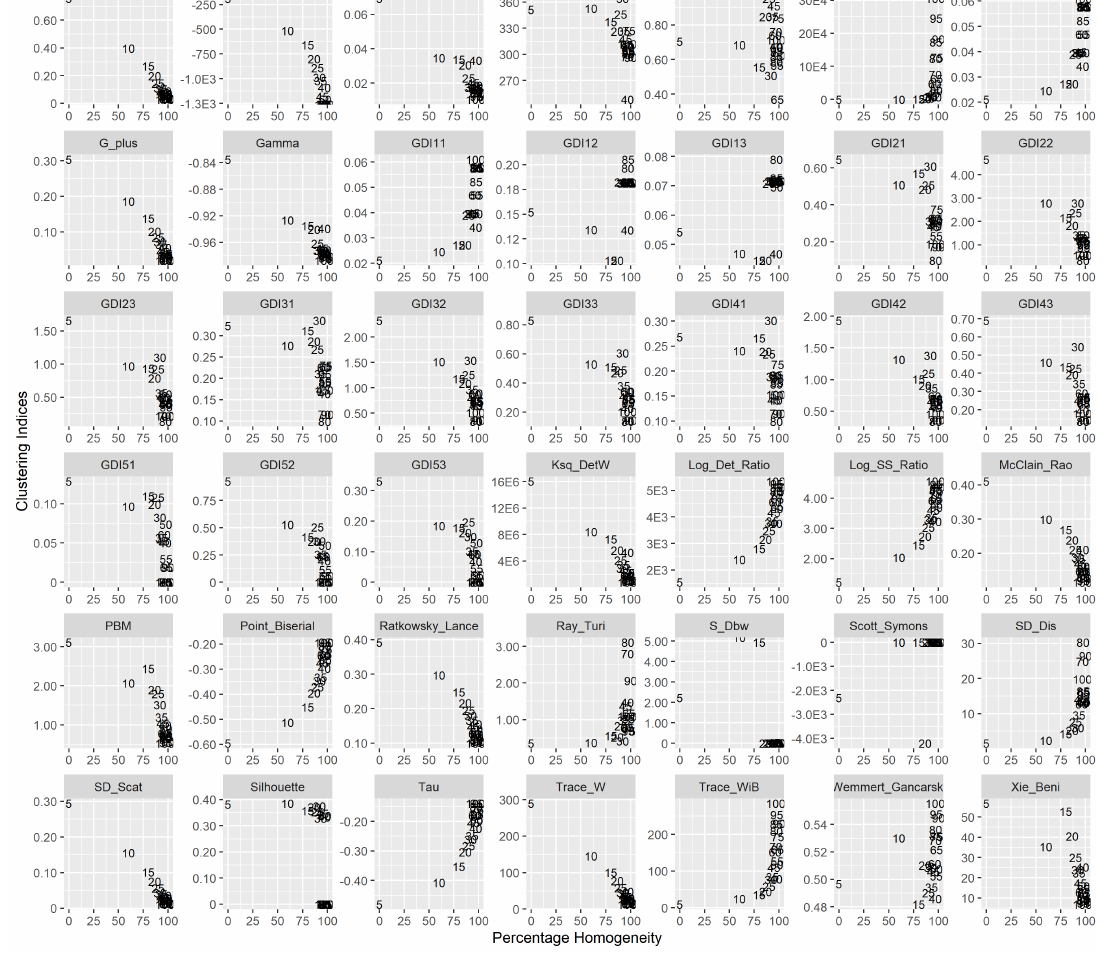
Figure 9. Performance of cluster validity indices in Great Lakes-St Lawrence lowlands (GL-SL) region—Winter season. The numbers indicate the percentage homogeneity for the number of clusters in the x-axis and index value on the y-axis. The scientific notation ‘E’ used in labels of y-axis represent ‘10 to the power